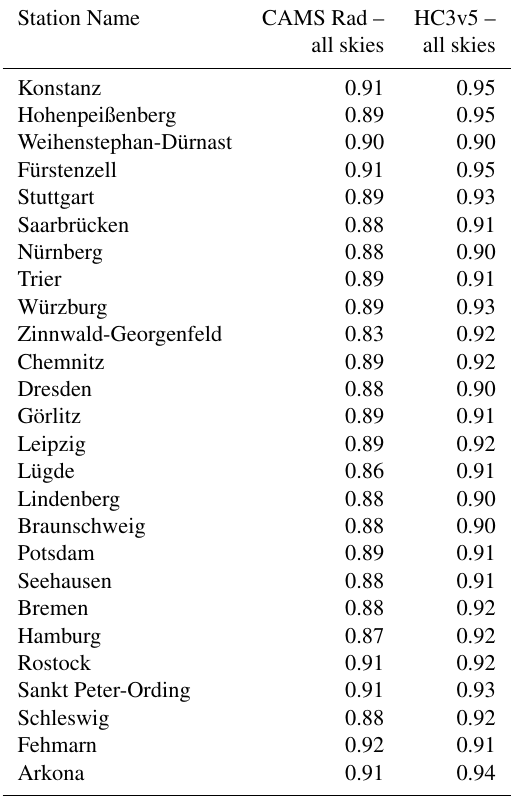
Table 2. Correlation coefficients for CAMS Rad and HC3v5 for all-skies, clear-sky and overcast